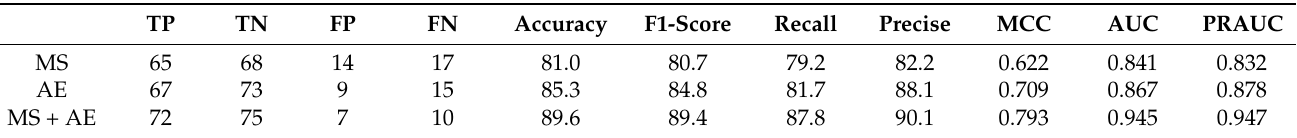
Table 3. The performance results compared by three types of combinations on